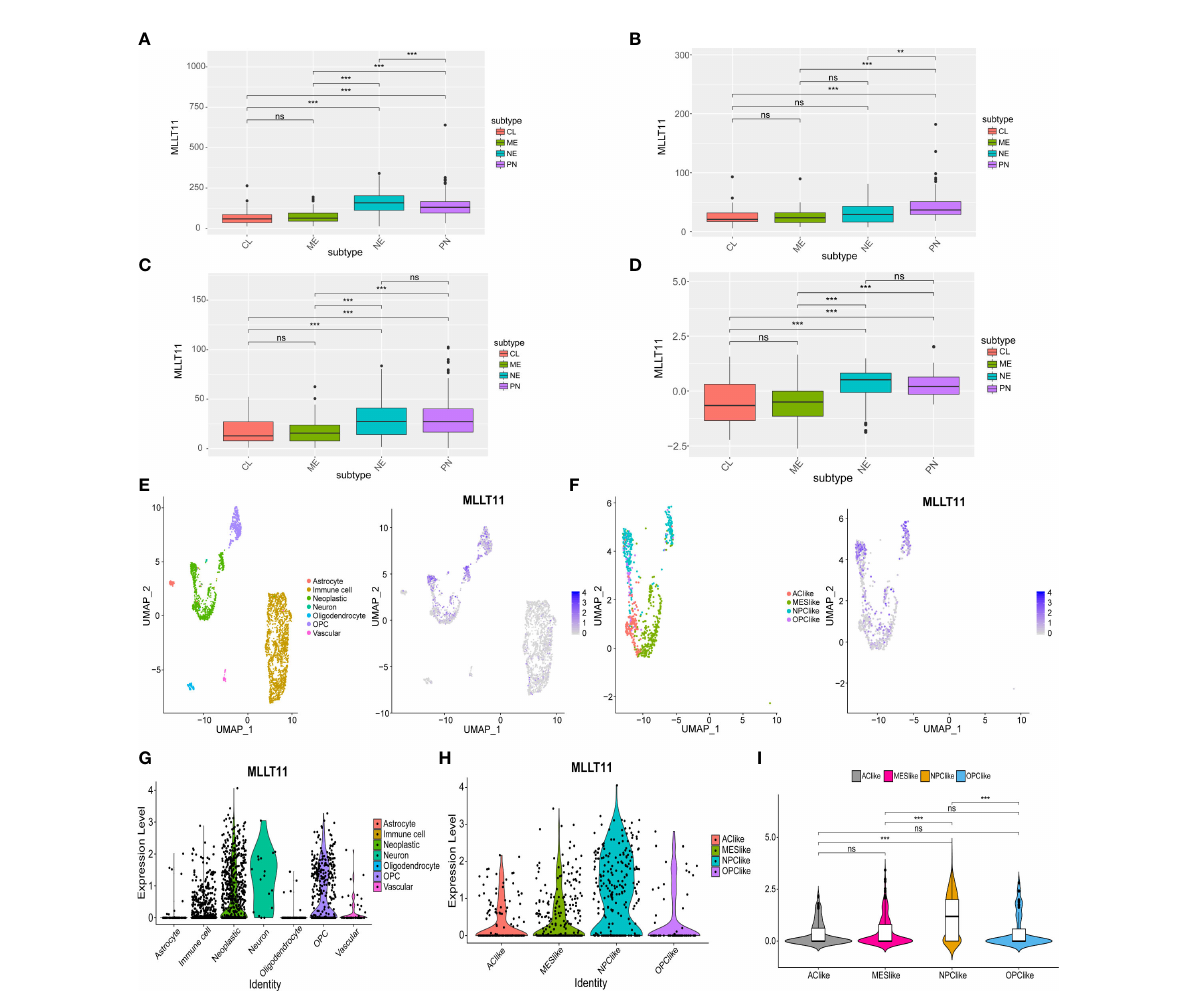
FIGURE 2 The expression of MLLT11 in different glioma subtypes. (A – D) MLLT11 expression level in different molecular subtypes in TCGA, CGGA_325, CGGA_691, and CGGA_array datasets based on bulk expression. (E – I) ScRNA-seq results for MLLT11 expression in GBM. (E) The cells were categorized into eight clusters (left). Blue scatter plots represent MLLT11 expression distribution in eight clusters (right). (F) Tumor cells were extracted and categorized into four different cell clusters based on the scRNA expression level (left), and MLLT11 expression is shown in blue scatter spots (right). (G, H) The expression levels of MLLT11 in the eight cell clusters and four molecular subtypes were shown by violin plot. (I) MLLT11 was mainly expressed in NPC-like subtypes compared with the other three subtypes. **p < 0.01, ***p < 0.001; ns, no